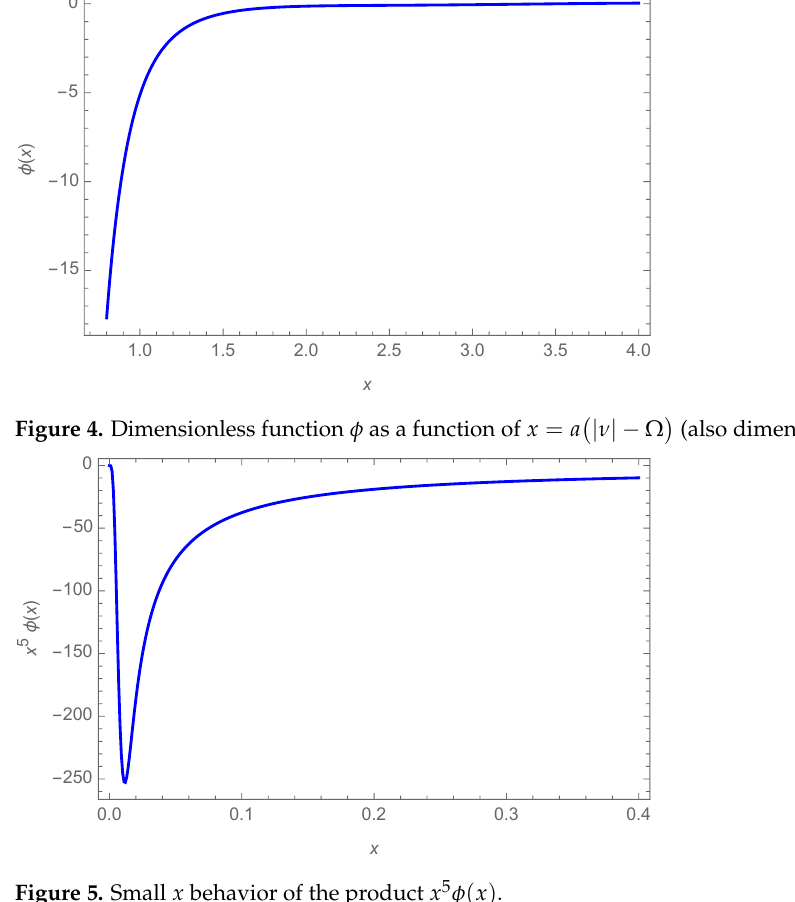
0.0 Figure 5. Small x behavior of the product x 5 φ ( x ) . The fact that m (cid:107) ( ν ) and m ⊥ ( ν ) have different signs also occurs for a moving atom in front of a perfect conductor. In that case, the different signs come from the evaluation of the two-point functions using the image